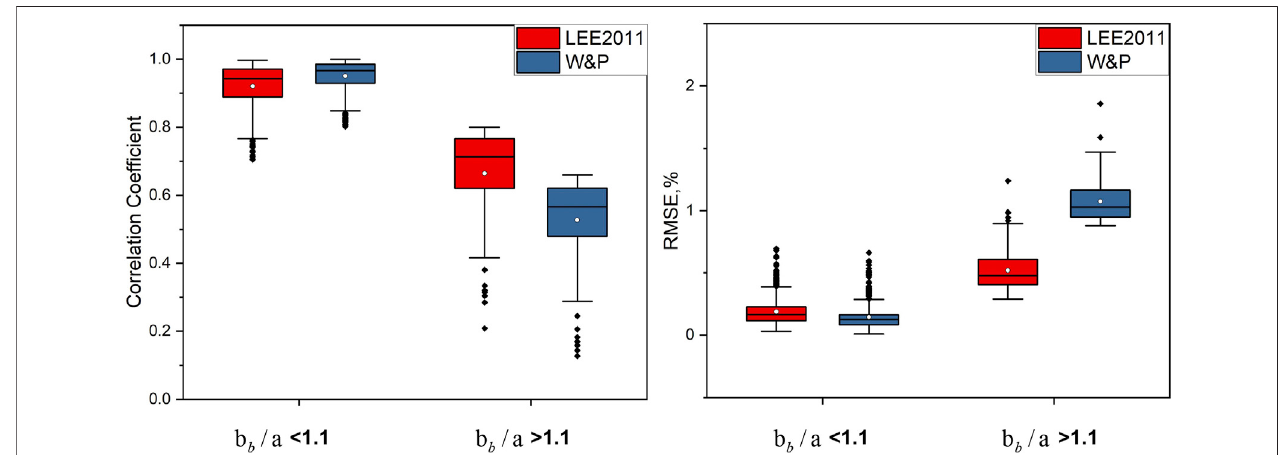
FIGURE 10 | Boxplots of the correlation coef fi cient and RMSE values at the Green Band for Lee2011 and Woerd-Pasterkamp2008 in two groups of water.